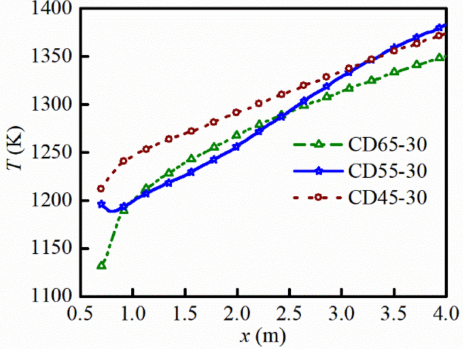
Figure 15. Temperature distribution of CD65-30, CD55-30, and CD45-30 near the furnace wall. As can be seen in Figure 16, as the angle decreases, the overall NO x concentration gradually increases. In addition, NO x is generated for CD55-30 and CD45-30 in the hood, because the amount of secondary air increases as the angle decreases to form a rapid NO x .